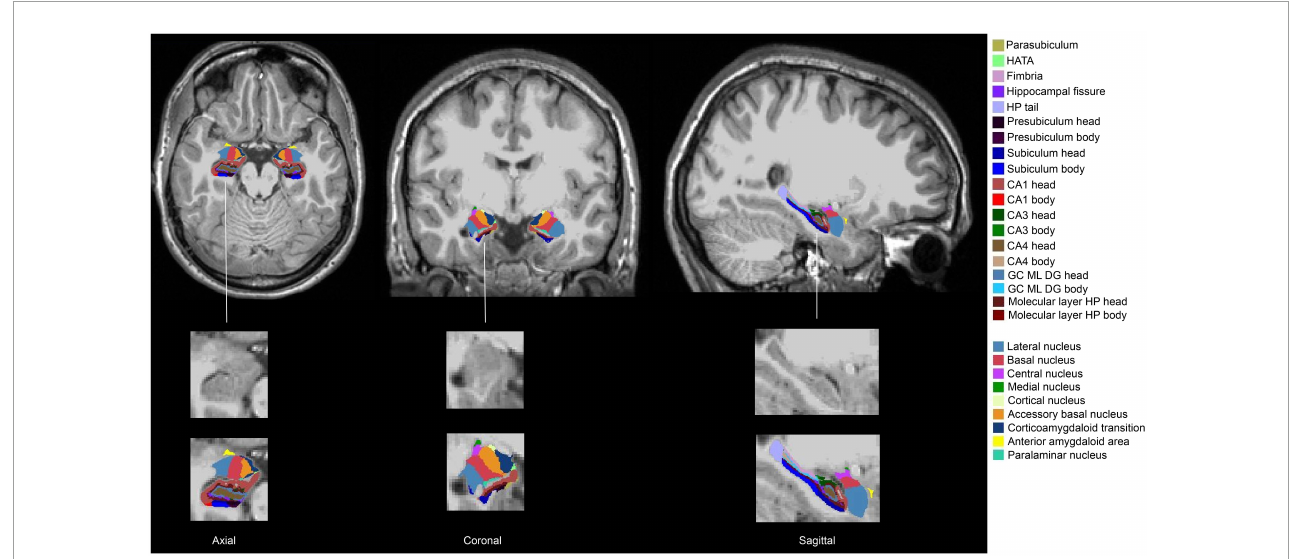
FIGURE1 Segmentation of the hippocampus and the amygdala of one Ice Storm participant. The columns from left to right represent axial, coronal, and sagittal views, respectively. The hippocampal subfields and the amygdala nuclei ( left and right ) were labeled with different colors. The second-row zooms in the right hippocampus and the right amygdala without any labels as the reference. The third-row zooms in the right hippocampus and the right amygdala with labels as the